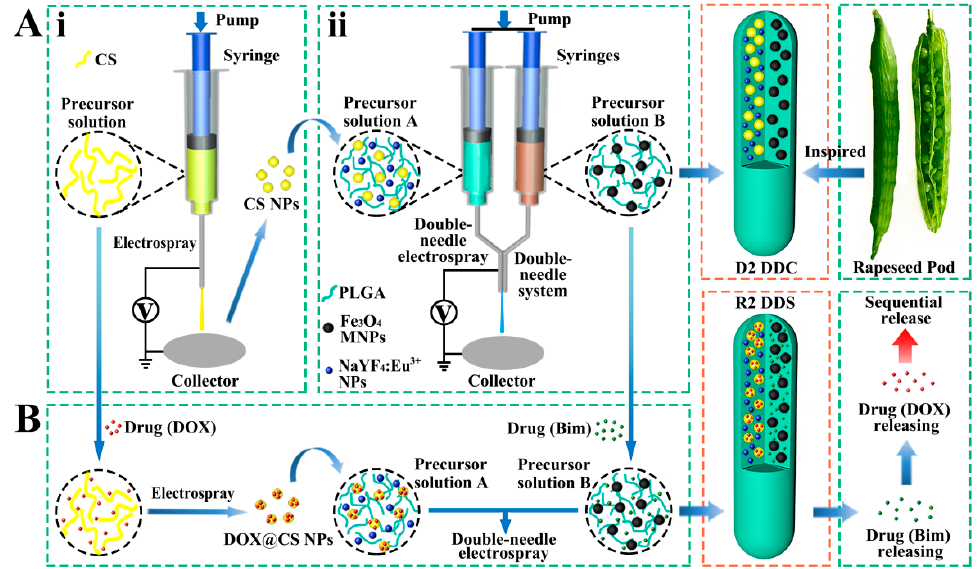
Figure 1. ( A ) Schematic diagram of the process of preparing magnetic–luminescent bifunctional rapeseed pod-like D2 DDCs: ( i ) schematic diagram of the preparation of CS NPs via electrospraying; ( ii ) schematic diagram of preparing D2 DDCs by double-needle electrospraying. ( B ) Schematic diagram of the process of preparing magnetic–luminescent bifunctional rapeseed pod-like R2 DDSs for the sequential release of dual